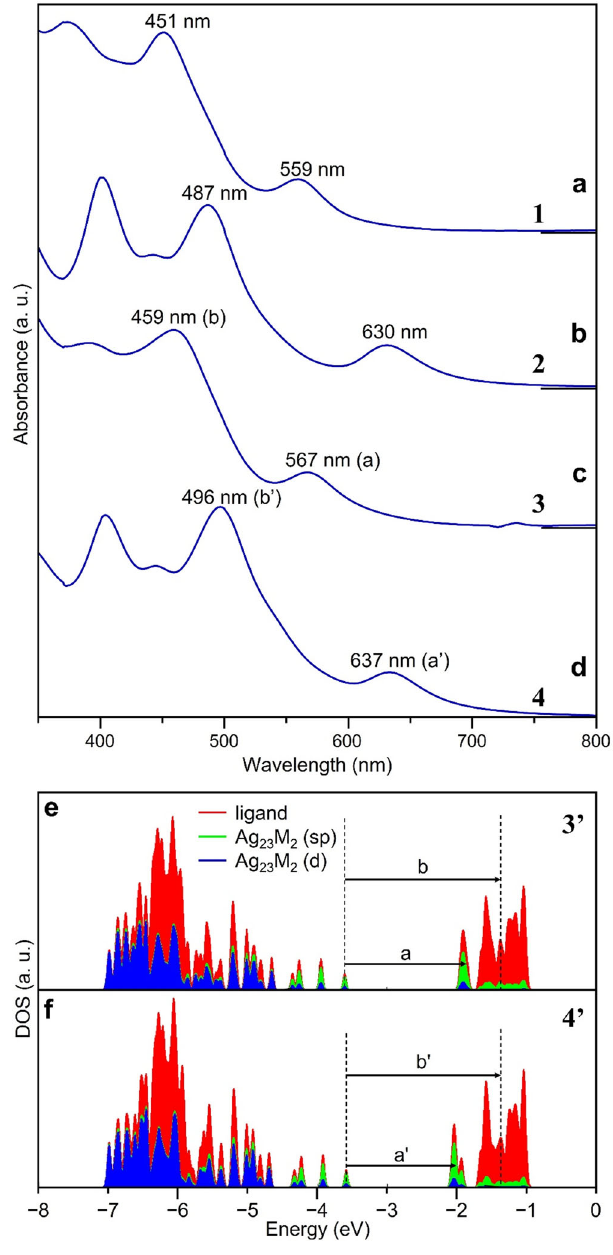
Fig. 4 Optical absorption spectra and analyses. a – d Optical absorption spectra of 1 , 2 , 3 and 4 , respectively. e , f Density of states of 3 ′ and 4 ′ , respectively. In e and f , a, b, a ′ and b ′ correspond to the peaks labelled as such in c and d (red = ligand; green = Ag 23 M 2 (sp); blue = Ag 23 M 2 (d)). structure caused by the change of the central atom from Pt to Pd was found to be due to these factors, similar to the case when Cl is used as the bridging halogen. We have also investigated the possibility that the red shift in the peak structure is caused by the twist due to the use of Br as a bridging halogen. Speci fi cally, we have calculated the optical absorption spectra also for [Ag 23 M 2 (PPh 3 ) 10 Br 7 ] 0 (M = Pt or Pd) without distortion (Figs. S20, S21). The results demonstrated that the optical absorption spectrum changes only a little depending on the twist, supporting the above interpretation that the main reason for the red shift in the peak structure is the change of the central atom from Pt to Pd.